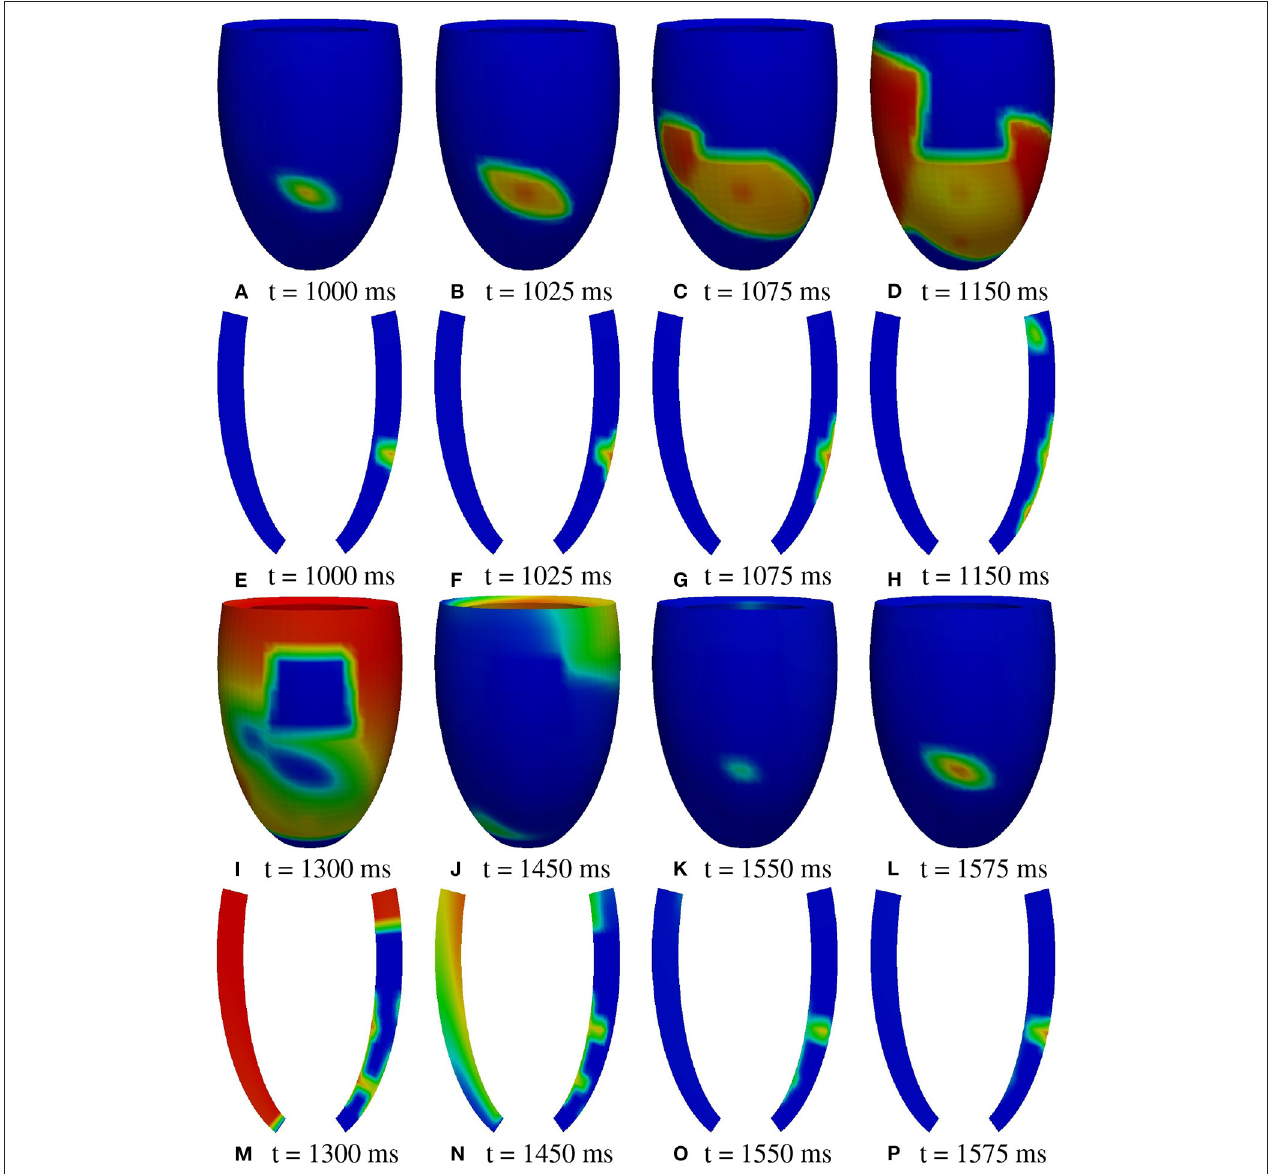
FIGURE 6 | Patient #1. M1 stimulation. (A–P) Transmembrane potential snapshots (t = 1,000–1,575 ms) on the epicardial surface and on a transmural section. t = 0 corresponds to the S1 stimulus. The S2 stimulus is applied at t = 350 ms. The colorbar is the same as in Figure 5